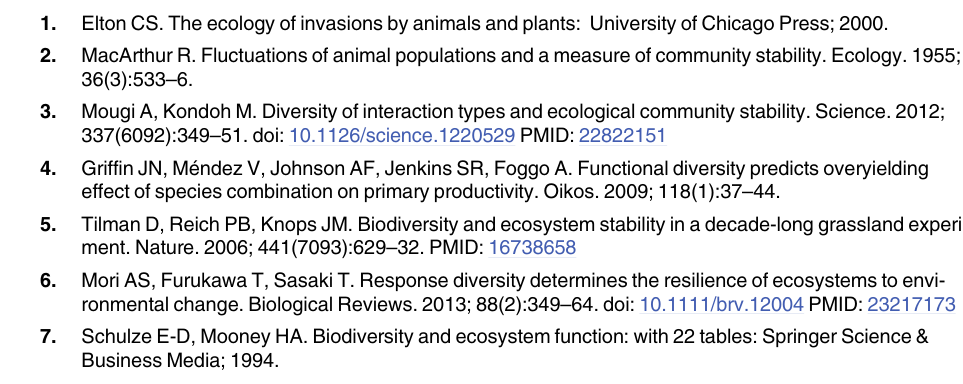
S1 Table. The minimum dataset underlying our